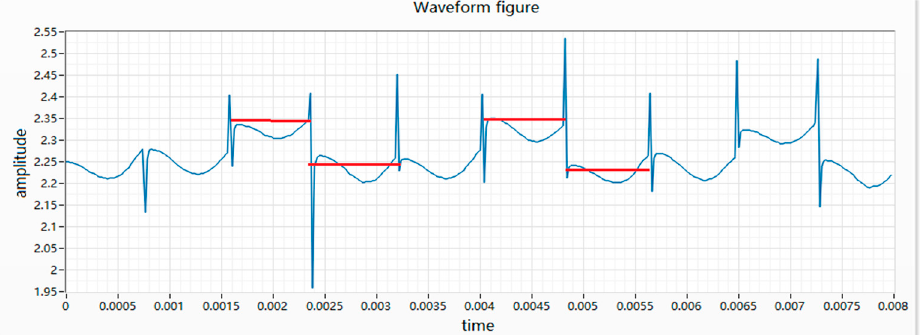
Figure 8. Waveform diagram of wave height.